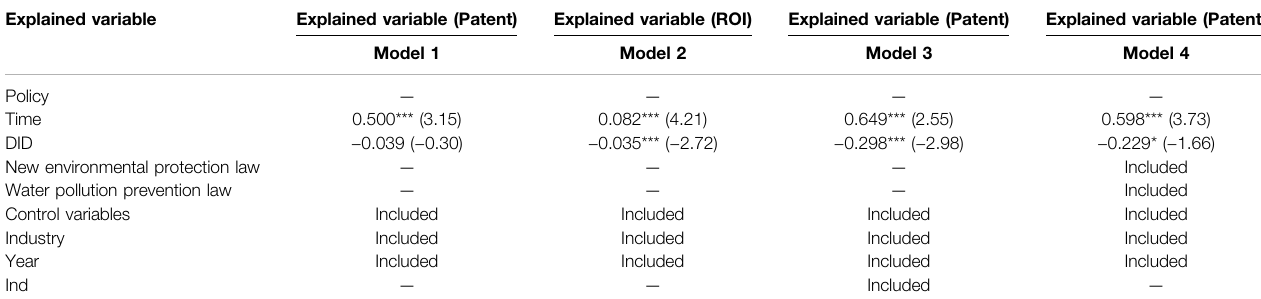
TABLE 4 | Robustness